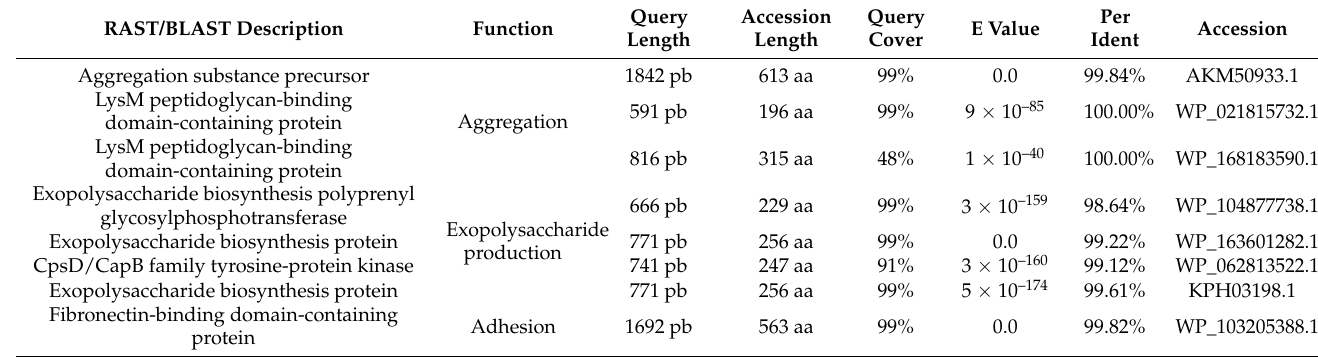
Table 3. Proteins potentially involved in the adhesion and aggregation properties of L. fermentum ATCC 23271 strain.